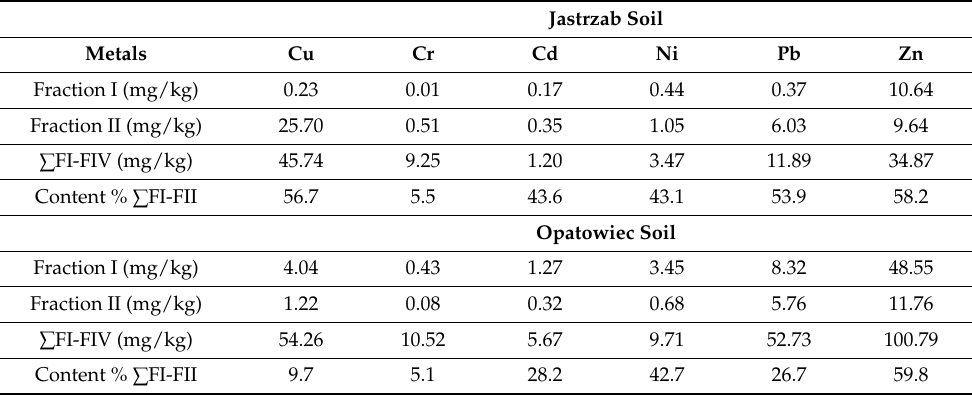
Table 5. Percentage % of heavy metals of the FI and FII fraction in the Jastrzab and the Opatowiec soils in relation to the total content of ∑ FI-FIV